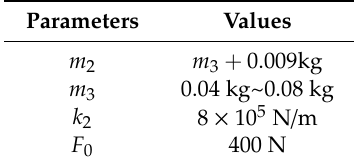
Table 4. The parameters of the